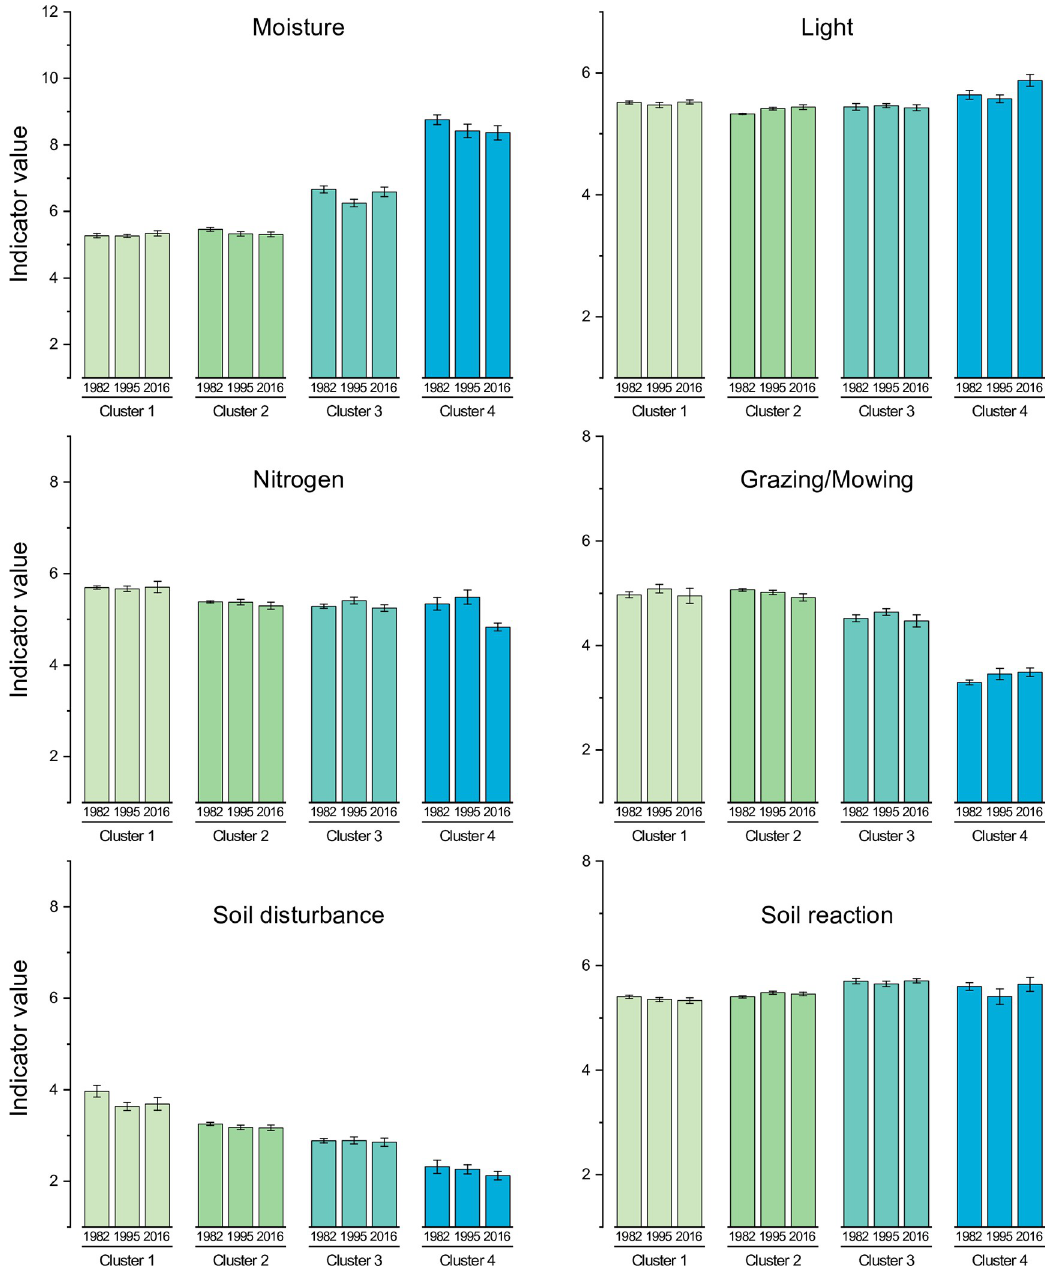
Fig 6. Estimated marginal means ± 1 S.E. for abundance-weighted indicator values for plots in Profiles 1–4 regarding Moisture, Light, Nitrogen, Grazing/mowing, Soil disturbance and Soil reaction in 1982, 1995 and 2016. Colours represent the four clusters with N values 12, 26, 21 and 17. The range of each y -axis covers the full range of the respective indicator. See S4 Appendix for mixed repeated-measures